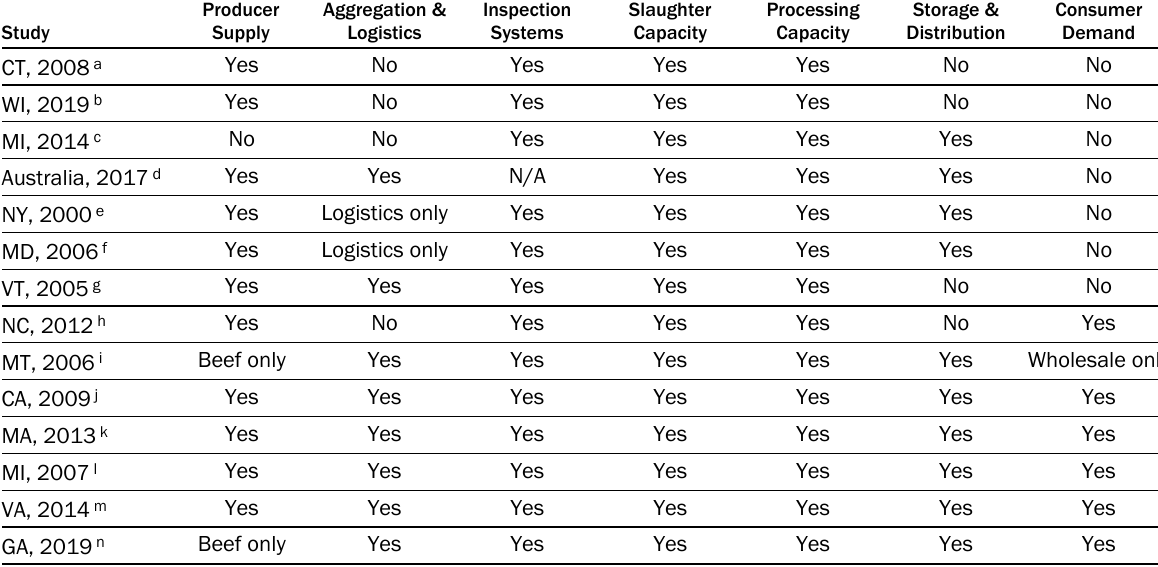
Beef only Yes Yes Yes Yes Yes